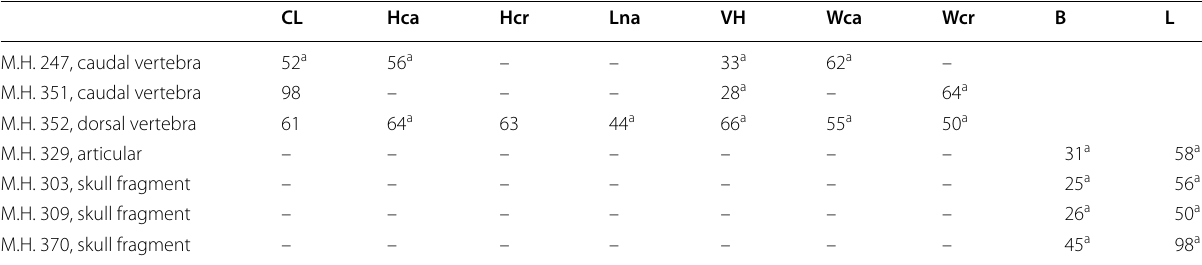
M.H. 350, theropod tooth: total preserved height 48.8 mm; length (mesiodistal) at base 18.1 mm; length at apex 2–3 mm; breadth (labiolingual) at = = = base 15.5 mm; breadth at apex 3 mm; length of complete serrated edge 19 mm = = = B preserved breadth or width of skull fragments, CL centrum length, Hca height of caudal articular surface, Hcr height of cranial articular surface, L preserved length of skull fragments, Lna length of neural arch, VH total vertebral height, Wca width of caudal articular surface, Wcr width of cranial articular surface. All measurement are in mm a indicates that the measurements refer only to preserved dimension at the incomplete